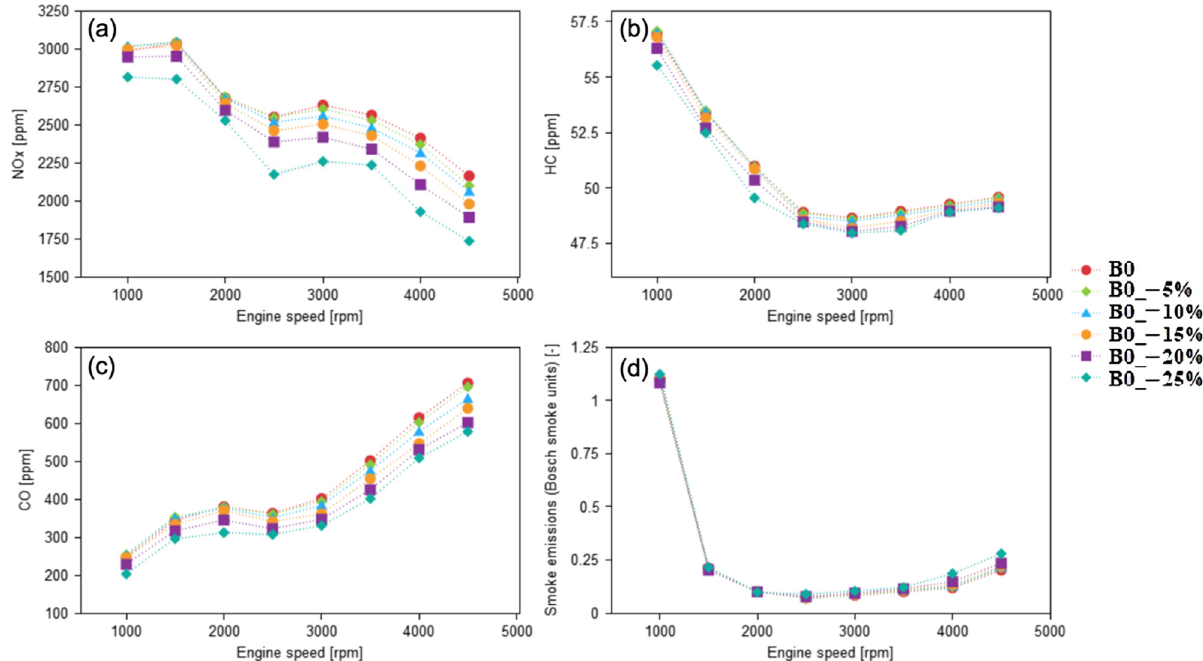
Figure 8. Comparison of emissions ( a ) 𝑁𝑂 𝑥 , ( b ) 𝐻𝐶 , ( c ) 𝐶𝑂 , and ( d ) soot, for B0 EIVC operation. 𝐶𝑂 emissions experience significant changes of − 13.8% at 1500 rpm and − 20.0% at 3500 rpm, respectively, for − 25% Miller cycle. For − 5% Miller Cycle effect, the 𝐶𝑂 emissions on average drop by 4%.